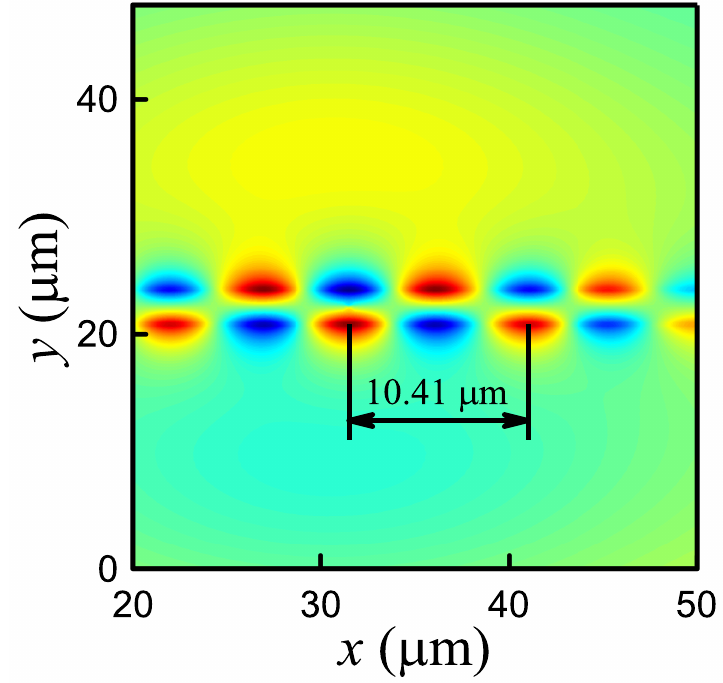
Figure 6. The spatial distribution of field component E y for SPP generated on a pair of graphene sheets. The FDTD method is our own implementation in MATLAB. The parameters correspond to those in [22]. Taking into account new values of conductivities [22]: σ 1 = 8.91 × 10 4 S/m and σ intra = 9.7 × 10 − 5 + 1.6 × 10 − 3 i S (slight differences from Hossain and Rana [22] are associated with calculation accuracy). The calculated value λ SPP + = 10.41